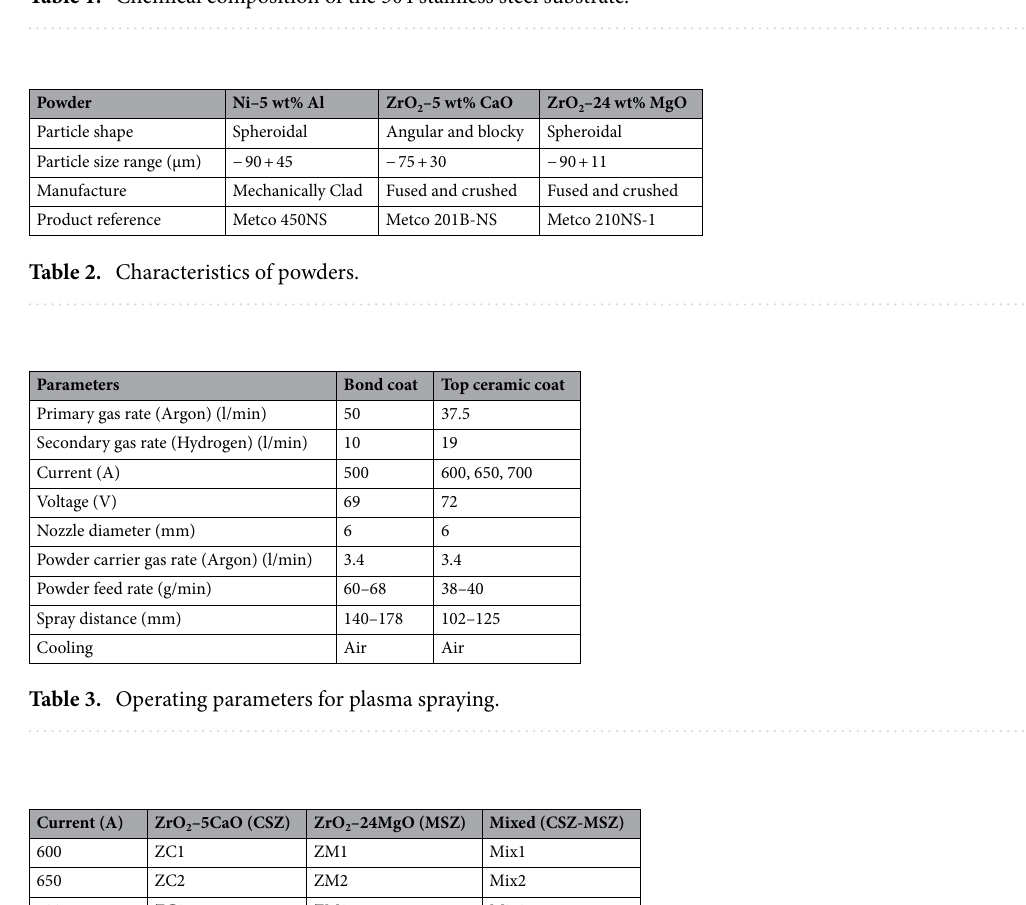
Table 1. Chemical composition of the 304 stainless steel substrate.